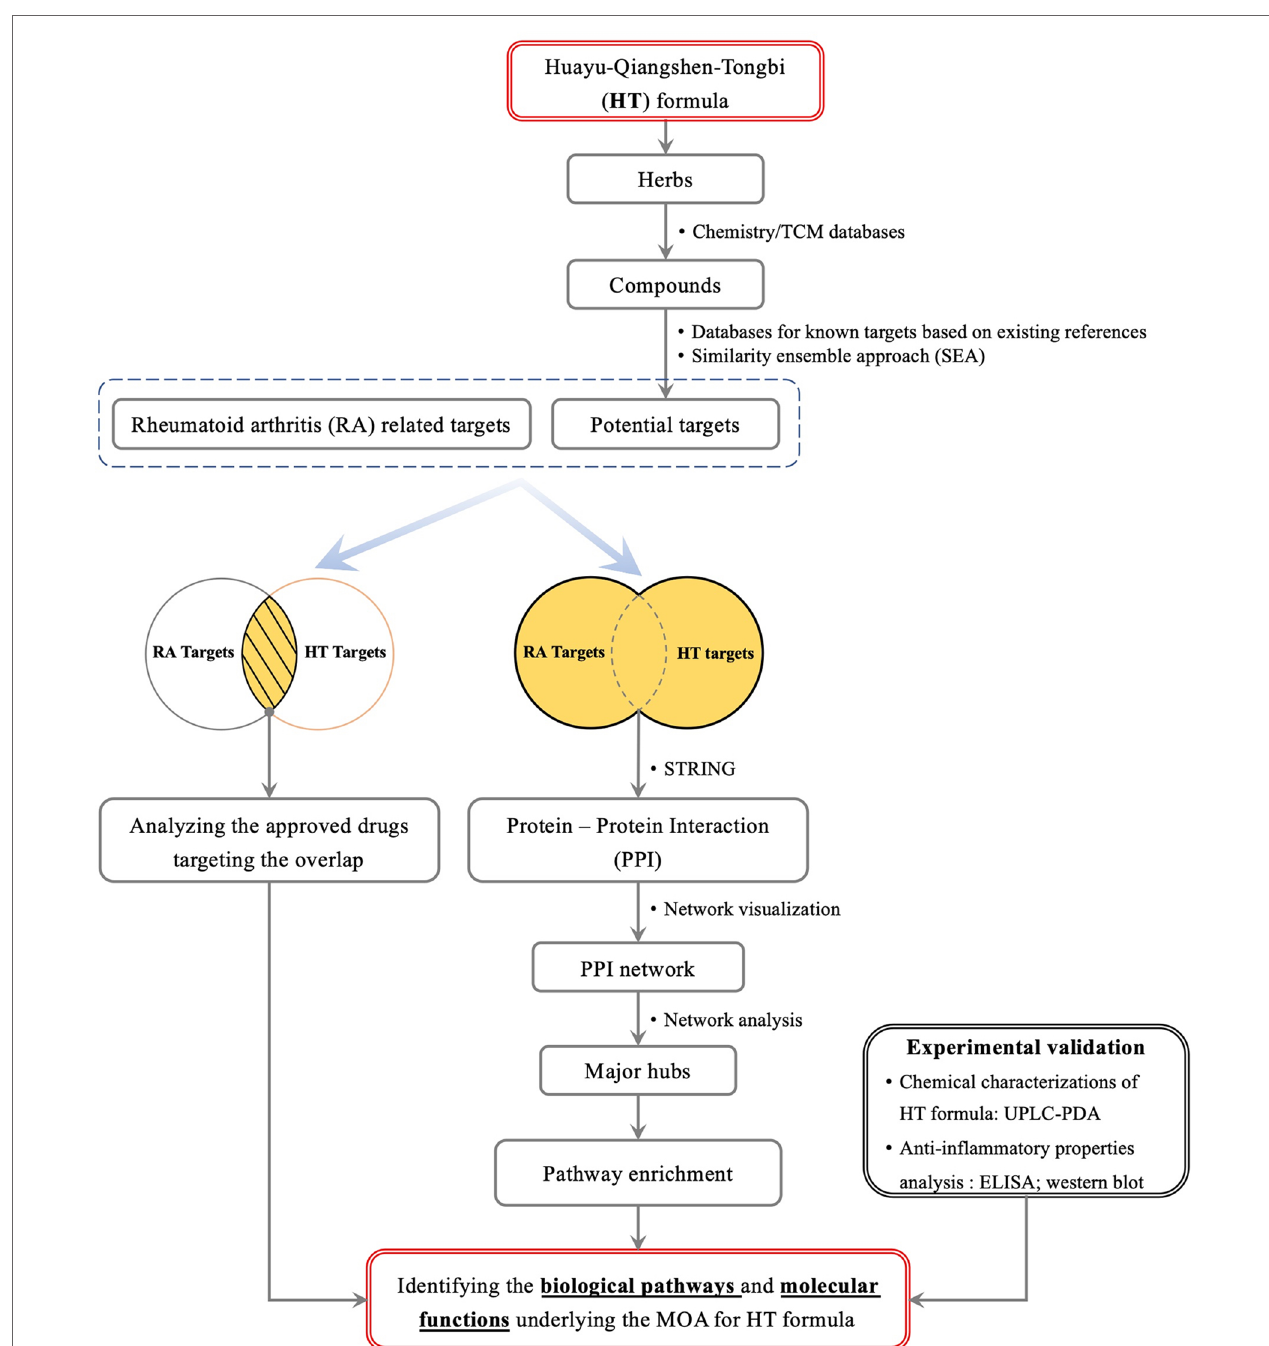
FIGURE 1 | A scheme illustrating the general workflow of studying the HT formula using a systematic